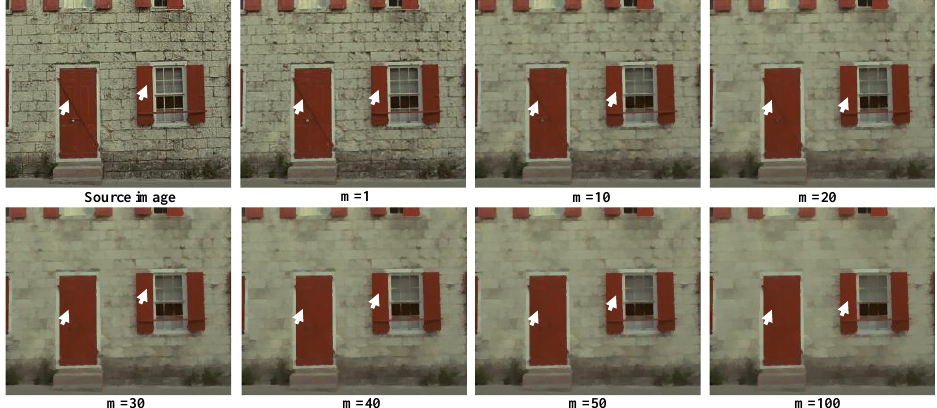
Figure 4. Multi-intensity edge preserving results of color image using MWMC with different m .